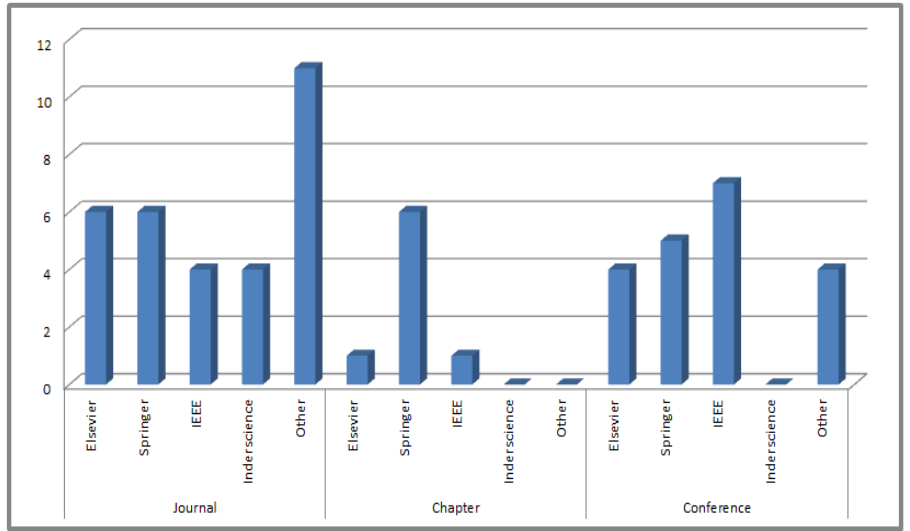
Figure 1. Number of publications on the Harmony Search Algorithm (HSA) since it was proposed until the first half of 2020, sorted by publisher and